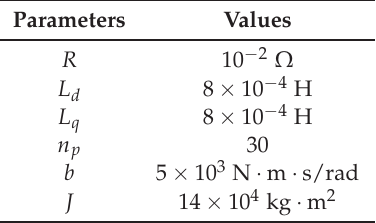
Table 3. D-SPMSG